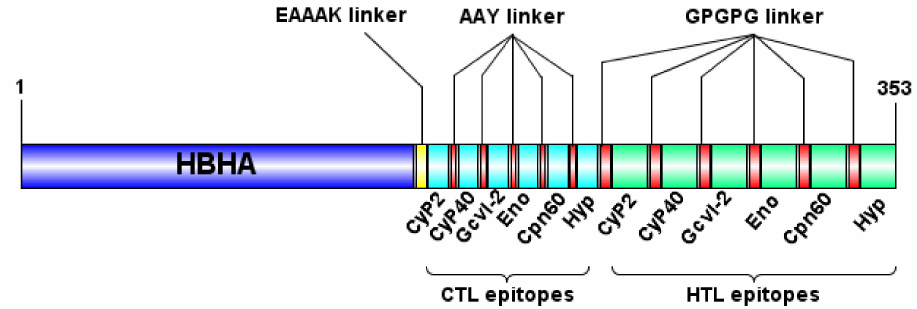
Figure 1. Schematic representation of the designed multi-epitope chimeric vaccine. The vaccine sequenceconsistedof353aminoacidresidues; thefirst159aminoacidsarerelatedtotheheparin-binding hemagglutinin (HBHA) adjuvant followed by 6 CTL epitopes and 6 HTL epitopes linked together by EAAAK, AAY, and GPGPG linkers,